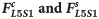
FL5S1candFL5S1s in relation to SS.Axial compression force (FL5S1c, upper plot) and anterior shear (FL5S1s, lower plot) at the L5S1 level computed at the minimum and maximum sacral slope values (SSmin and SSmax) in the four lumbar typologies (RT1, RT2, RT3, RT4). SSmin and SSmax are, respectively, 25° and 35° for both RT1 and RT2, 35° and 45° for RT3, 45° and 55° for RT4 (Table 1). The results correspond to the central pelvic incidence (PI) values for the RT (40° in RT1 and RT2, 50° in RT3, 60° in RT4, see Table 1). The three sagittal vertical axis (SVA) conditions interpreting the balanced global alignment (SVAmed) and the backward and frontward imbalanced alignments (SVAback and SVAfront) are presented as green, blue, and red bars, respectively. The lumbar lordosis (LL) is reported as well.